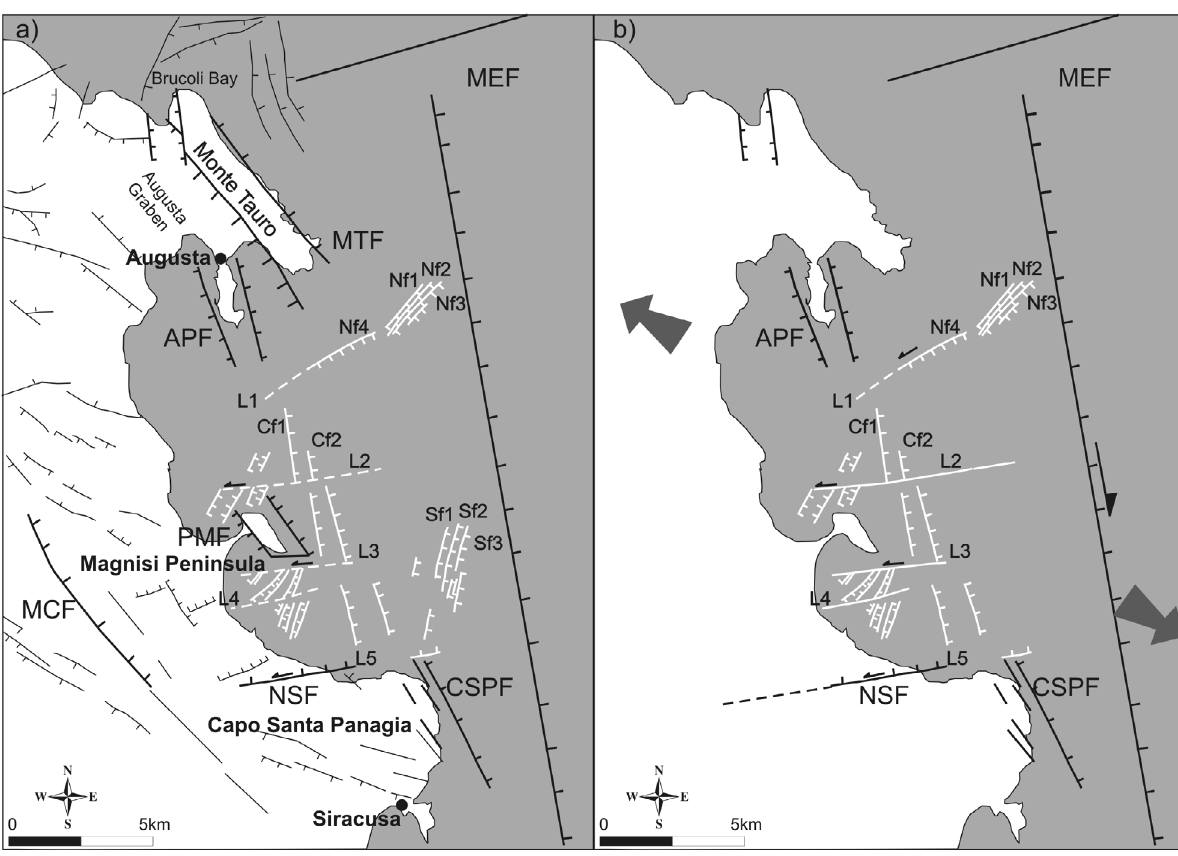
Figure 13. a) Sketch map of the Augusta Basin showing all the faults observed by Chirp profiles, deduced by the morphobathymetric and geo- morphological analyses, related to the faults of the entire structural background reported in the literature; b) structural features of the Augusta Basin with active faults observed by Chirp analysis in relation to the APF, NSF and CSPF, of which they may be the likely offshore continuation, and in relation to the MEF (according to Ambrosetti et al. [1987]) of which they are the probable incipient westernmost